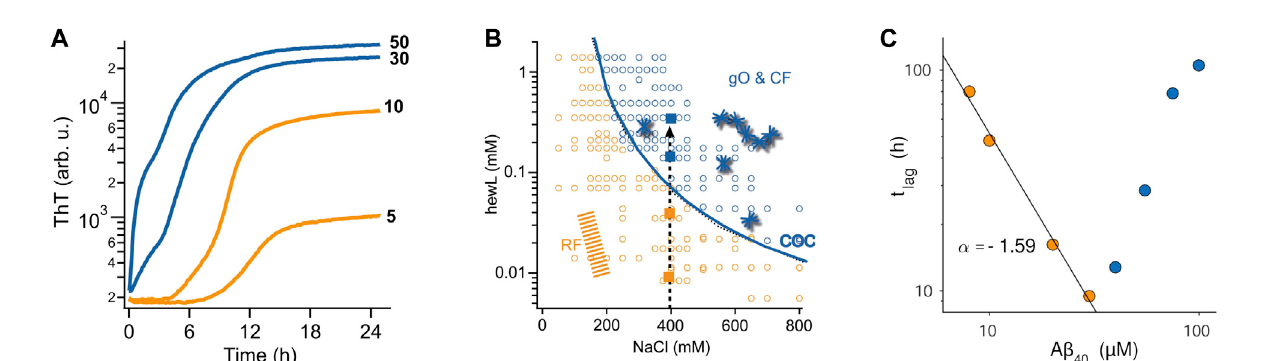
FIGURE 2 Effects of oligomers on the kinetics of fi bril assembly (A) Kinetic transition from purely sigmoidal (orange) to biphasic (blue) ThT kinetics for A β 42 assembly at pH 7.4 (50 mM sodium phosphate) and 27 ° C. ThT fl uorescence is plotted logarithmically to highlight the fl atness during the lag phase in the sigmoidal regime. As discussed, this kinetic transition is consistent with both NCC and off-O formation (B) Kinetic “ phase diagram ” for the onset of biphasic oligomerformation(blueline)duringlysozyme fi brilgrowthatpH2.While fi brils(orange&bluedots)willeventuallyformforallprotein/saltcombinations in this diagram, biphasic oligomers only emerge beyond the conditions outlined by the solid blue line. This uncoupling of favorable conditions for fi bril vs. oligomer isanother indicatorfor off-pathway oligomers. (C) Plot ofthelag phasefor fi brilformation ofA β 40 atpH 7.4as function ofproteinconcentration. In the sigmoidal regime (orange dots) the lag phase decreases as a power-law in protein concentration (black line), as expected for nucleated polymerization. The onset of biphasic oligomer formation (blue dots) reverses this trend. This inhibitory effect on fi bril nucleation is a strong indication for off-pathway oligomers. Figures 2A, C are adapted from ref (Hasecke et al., 2021) and Figure 2B is adapted from (Hasecke et al.,